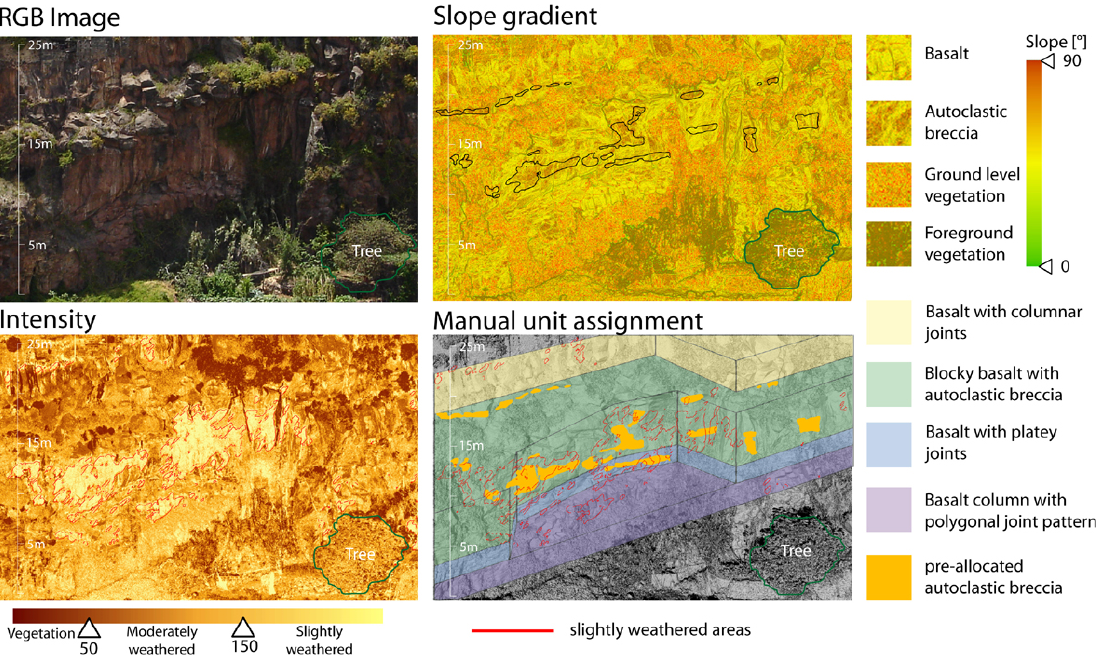
Fig. 5. Transformation of TLS outcrop data into 2-D relief data allows performing a slope gradient and intensity analysis for a pre-allocation of geological units and their weathering conditions in a GIS environment. Supported by the manual assignment of unit boundaries from a virtual outcrop model, evaluation and comparison of different sources allow the characterization of the